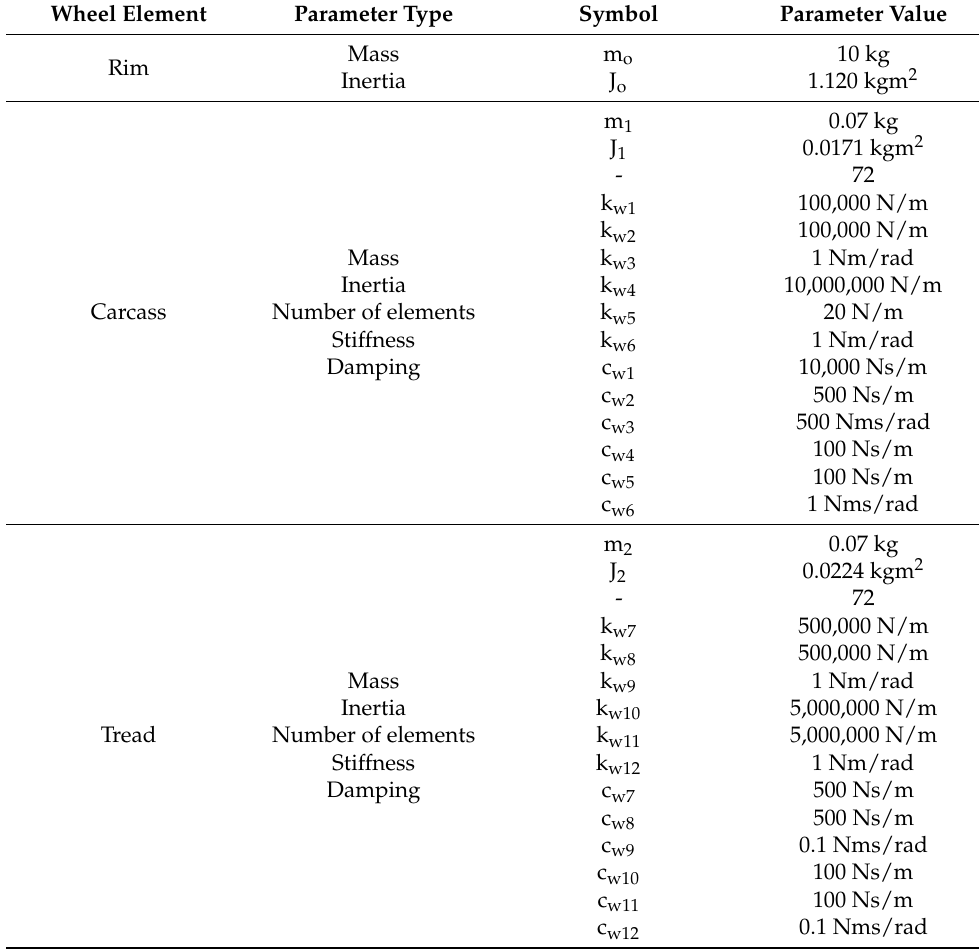
Table 2. Values of main wheel model parameters. Wheel Element Parameter